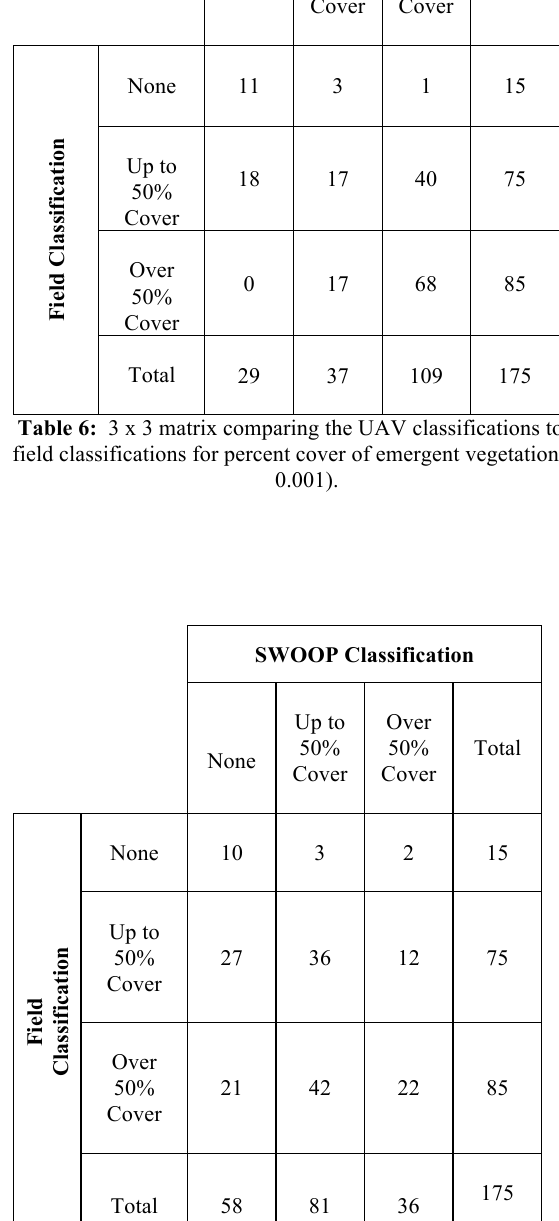
Table 7: 3 x 3 matrix comparing the SWOOP classifications to the field classifications for percent cover of emergent vegetation ( p =